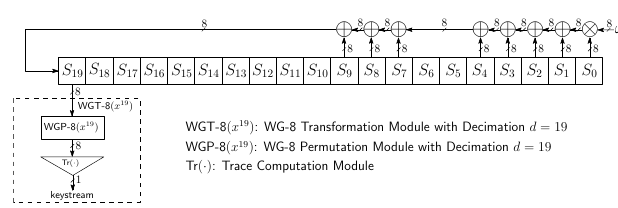
Figure 2. The Running Phase of the Stream Cipher